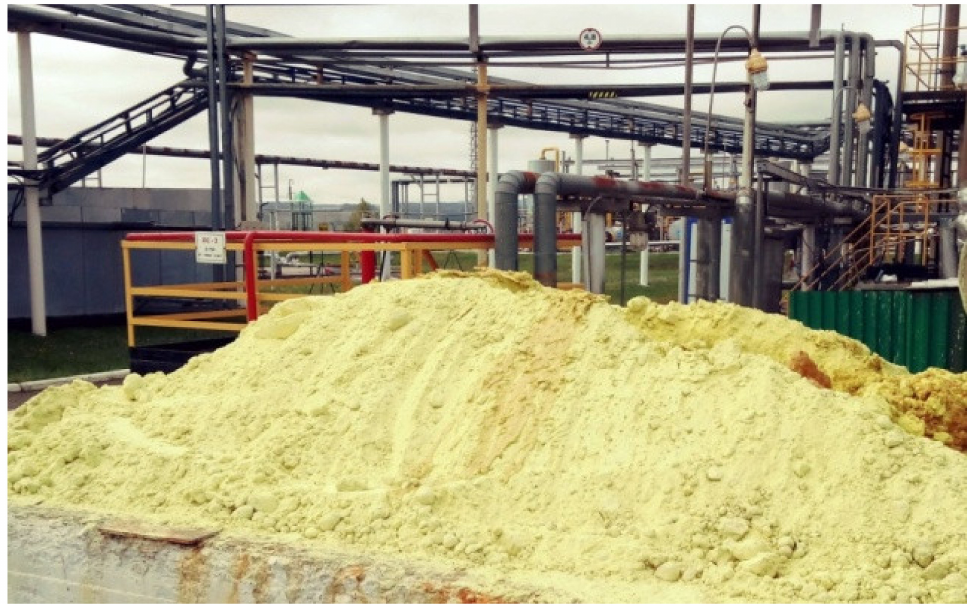
Figure 25. Sulfur produced at the Bavly gas shop of PJSC Tatneft.